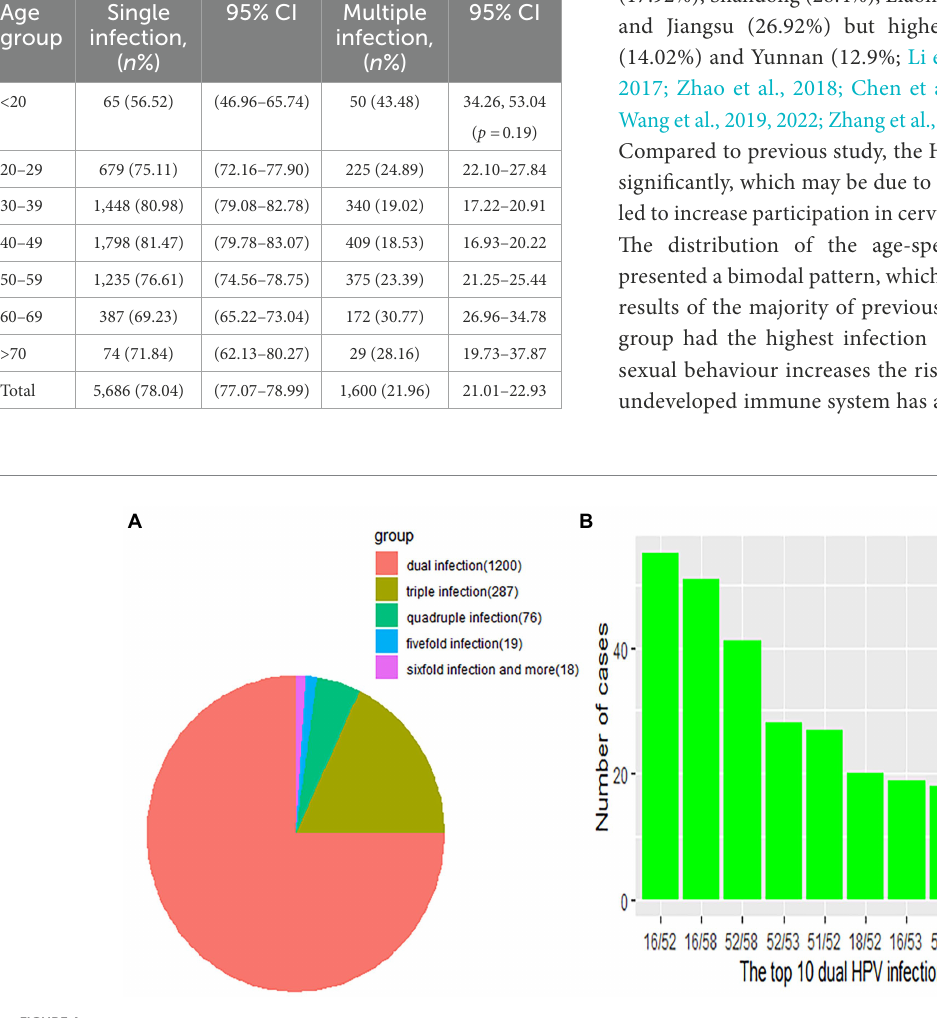
FIGURE 4 (A) Distribution of multitype HPV infection. Each part represents the number of cases due to multiple HPV infections. Orange, red, olivine, green, blue and violet indicate the number of dual, 3-strain, 4-strain, 5-strain, and six-strain or more infections, respectively. (B) The green bar represents the number of the top 10 dual HPV